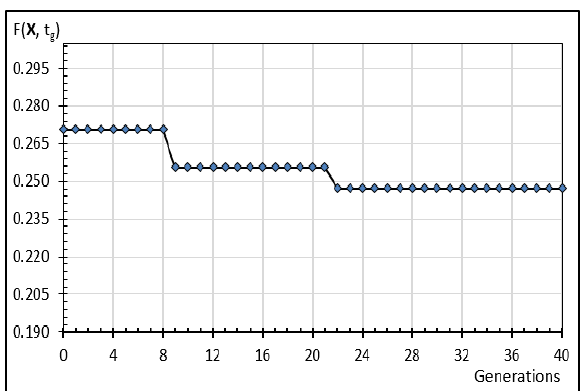
Figure 5. Fitness functions for the best individuals found over the generations.